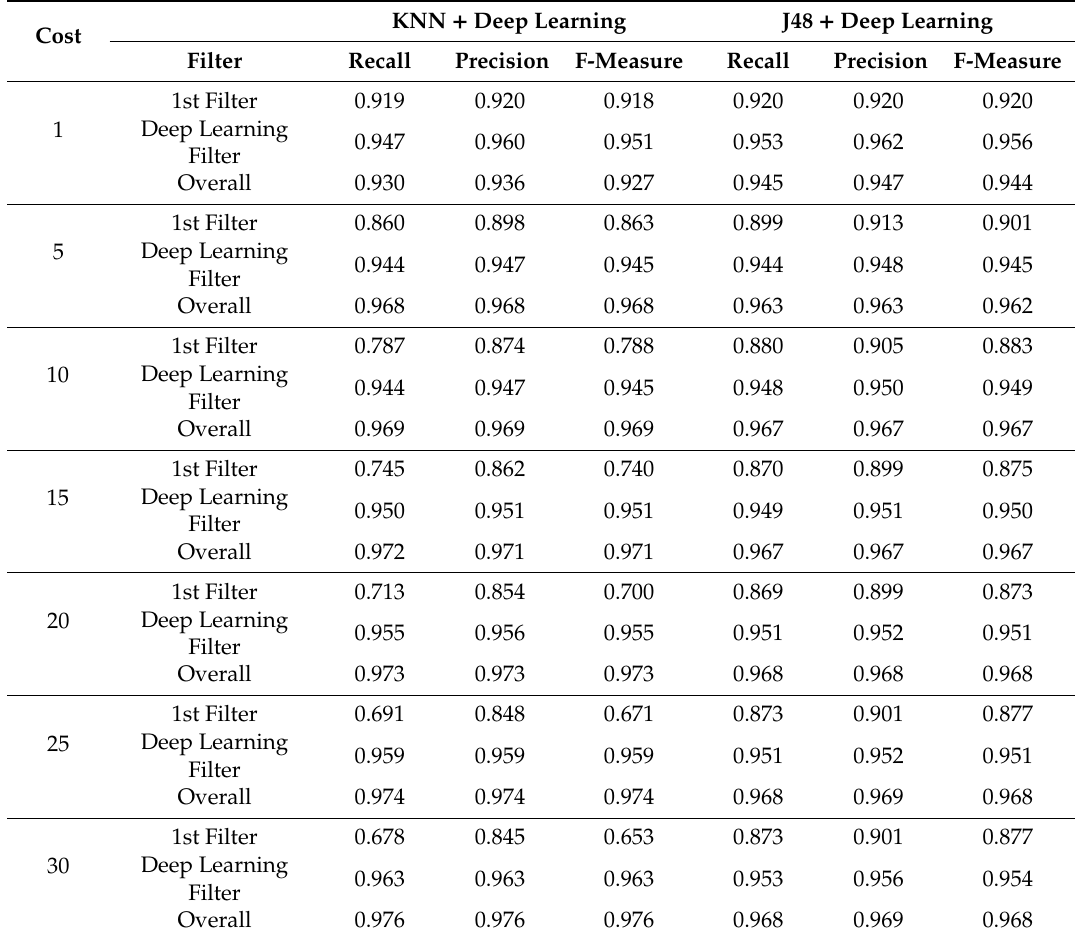
Table A1. Detailed classification accuracy of each filter according to cost